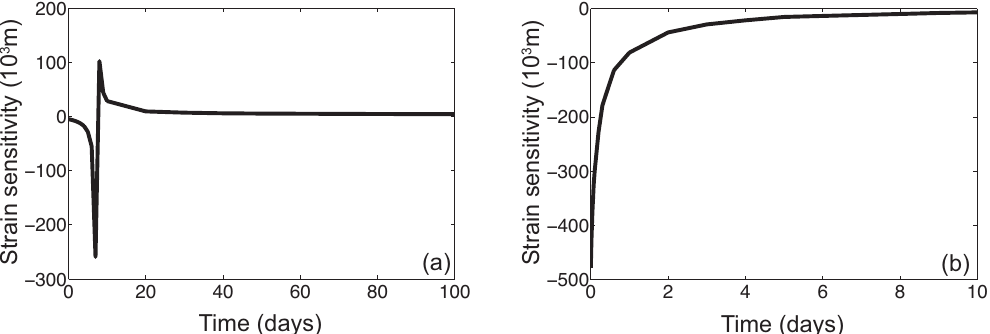
Figure 15. Strain sensitivity in the aquifers, determined at a point centrally above the chamber for different simulation times. (a) pyroclastic aquifer, (b) lava flow aquifer. The value significantly changes with time, depending on flow processes in the aquifers.